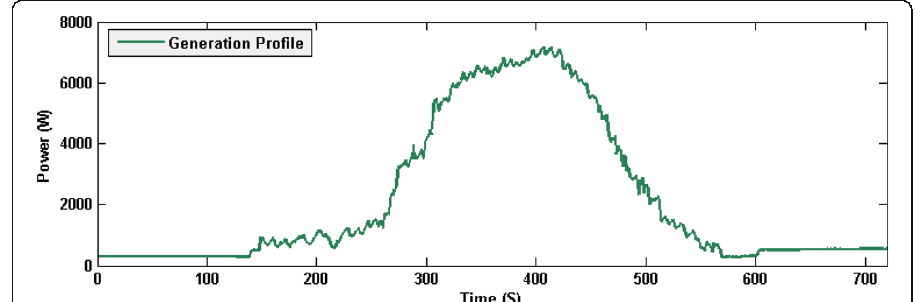
Fig. 12 Real-time profile of aggregated generation from BUS #15, #10, and